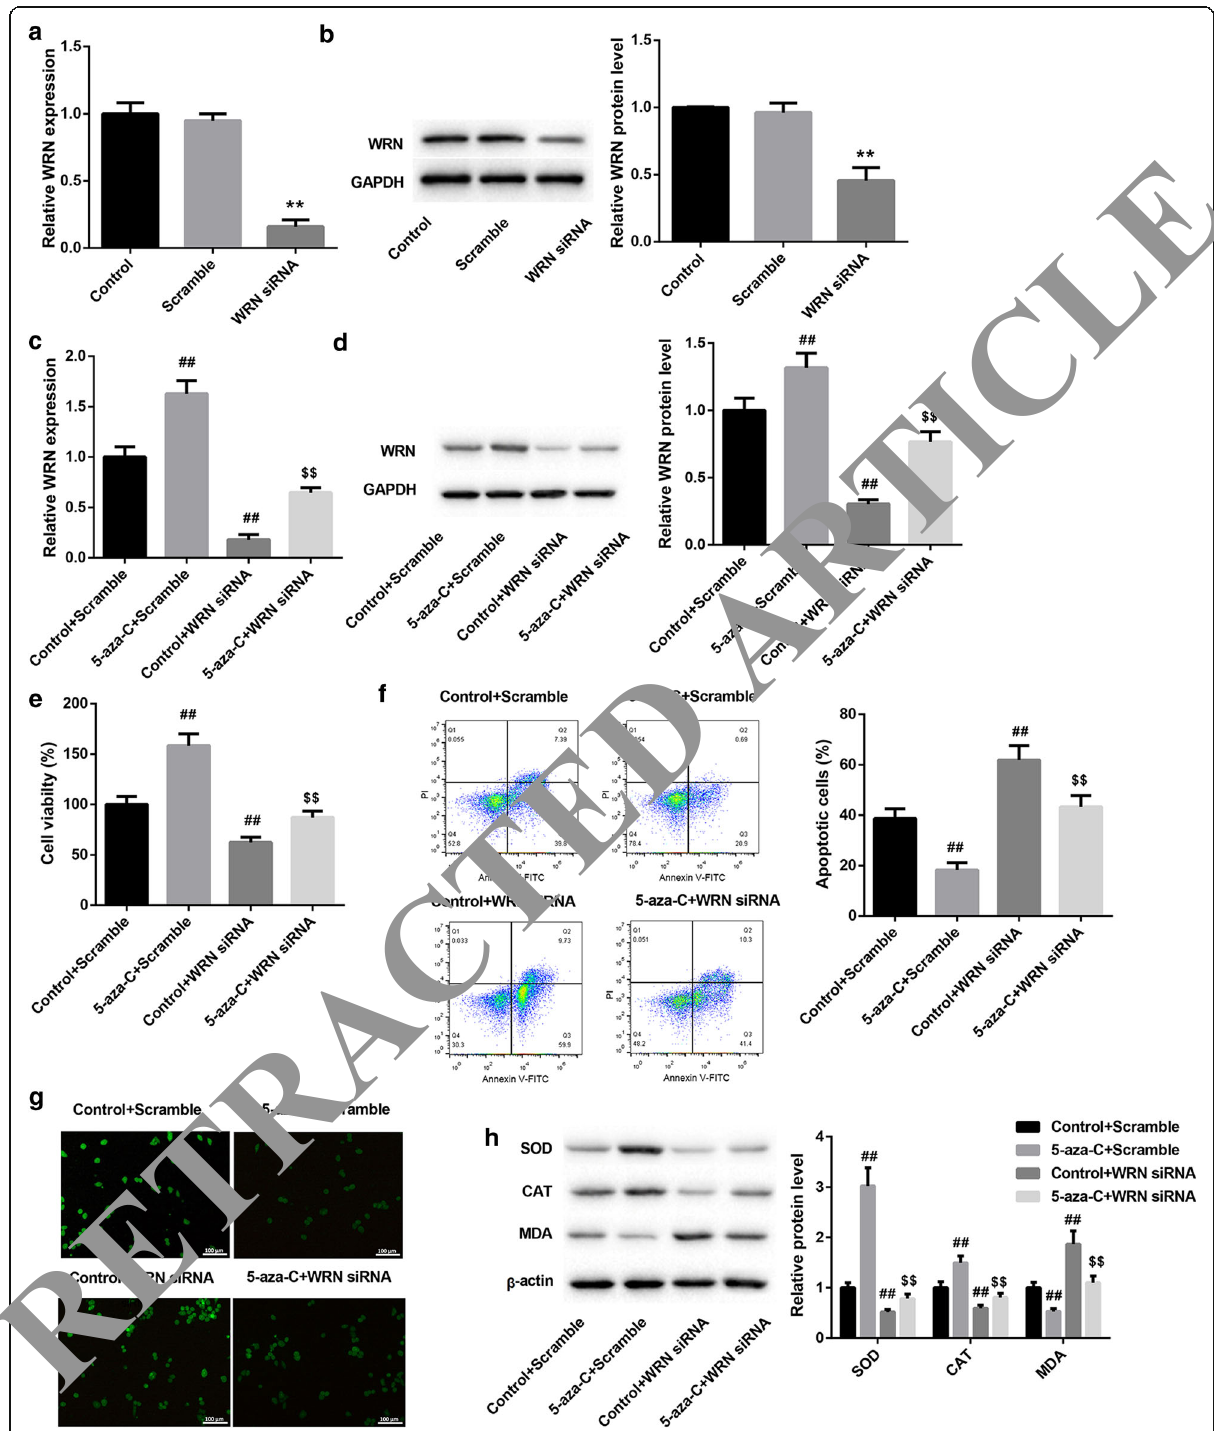
Fig. 4 (See legend on next